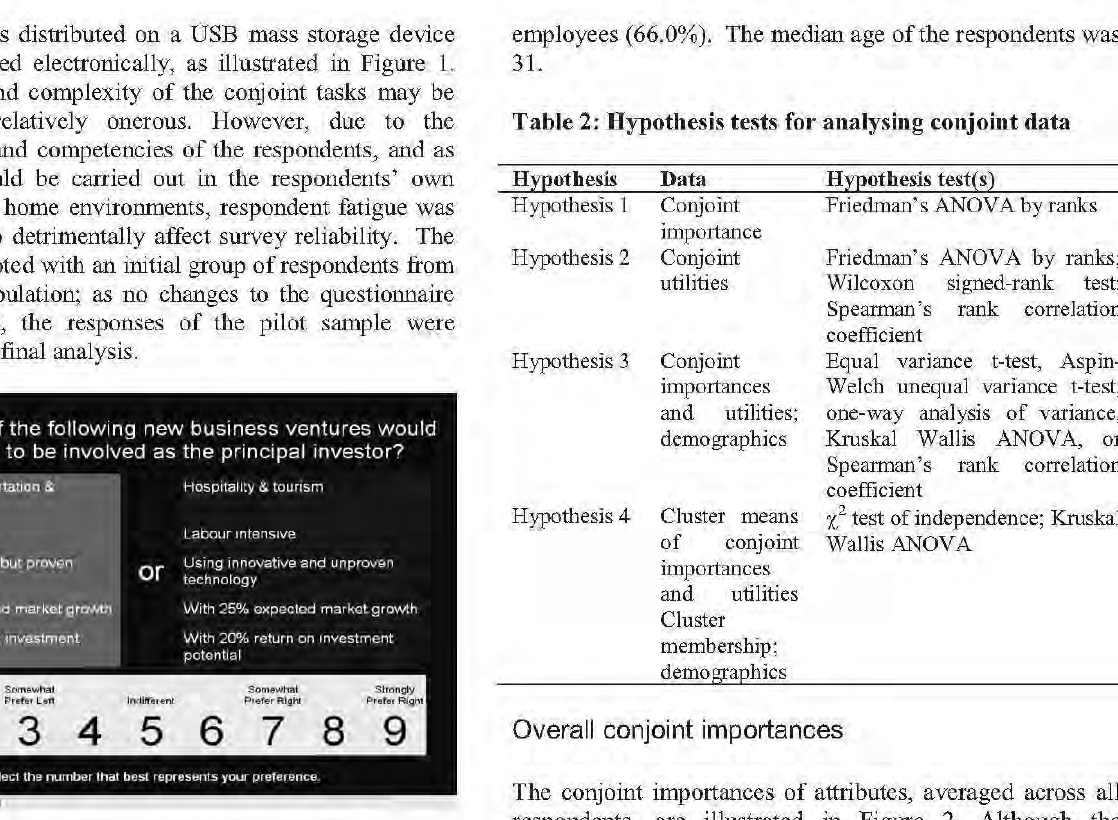
Figure 1: Pairwise comparison conjoint task survey screen